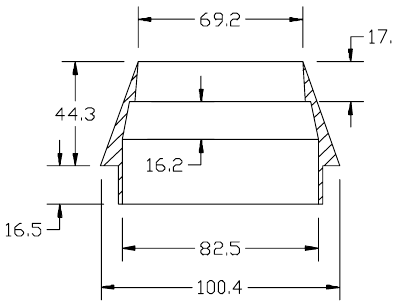
Figura 1. Ponteira de cravação do amostrador (dimensões em mm).